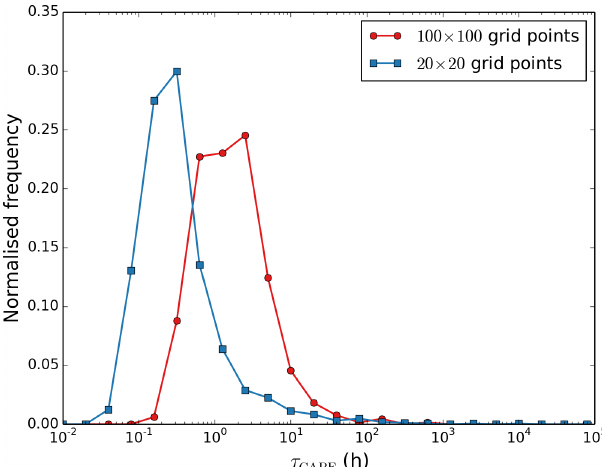
Figure 6. Normalised frequency distribution of convective timescale of deep convection from analysis of a small region of the Indian Ocean at resolutions of 100 × 100 and 20 ×